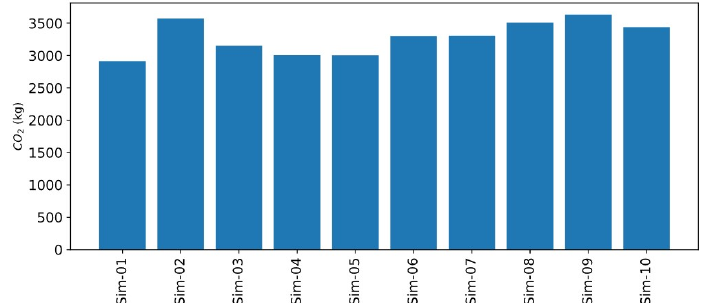
Figure 5. Carbon emission of the beams as a function of